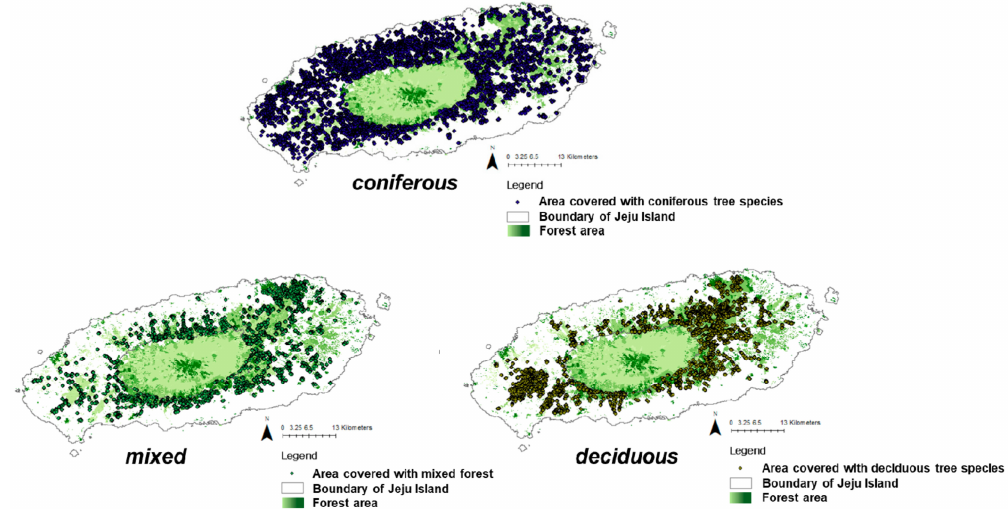
Figure 1. Distribution of sample points on Jeju Island. Random points were equally generated based on boundaries of classes of age, density, and diameter size under 500 m in the study